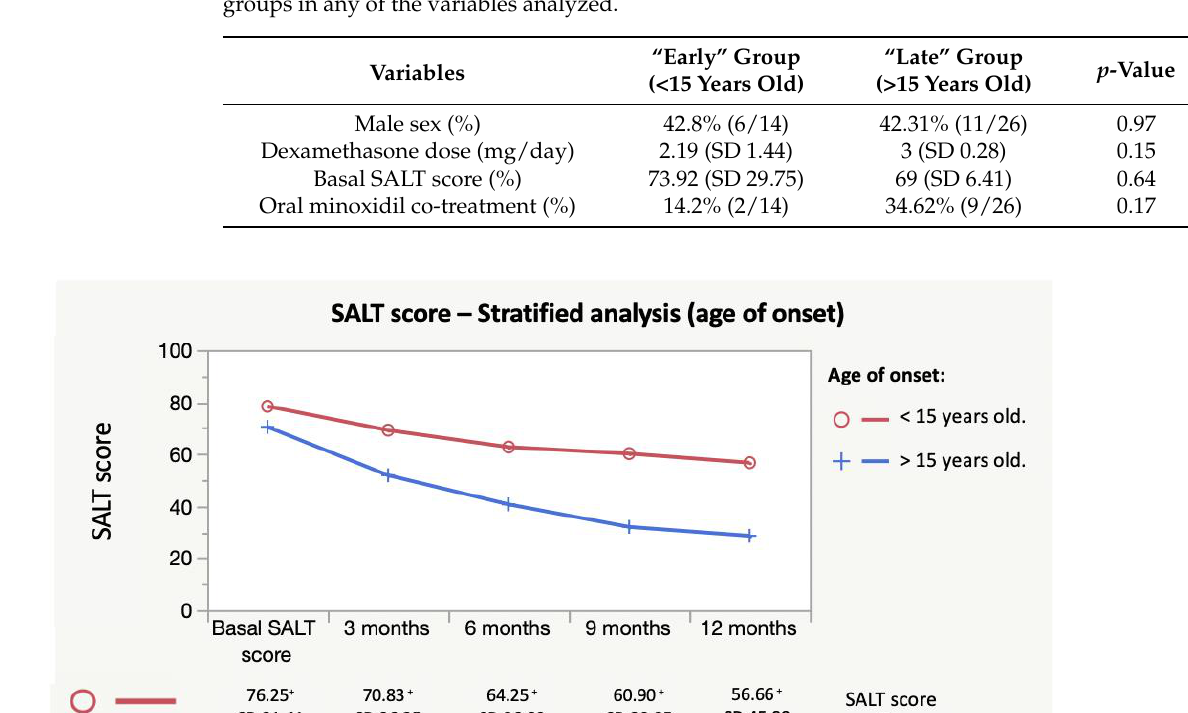
Figure 3. Stratified analyses for latency time for treatment and hypothyroidism did not find significant differences between groups.